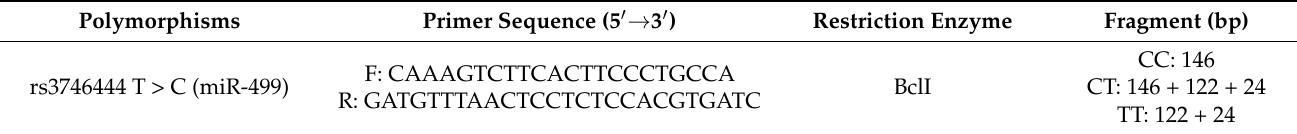
Table 6. Primer sequences were used for the detection of miR-499 rs3746444 T > C by the PCR-RFLP method.